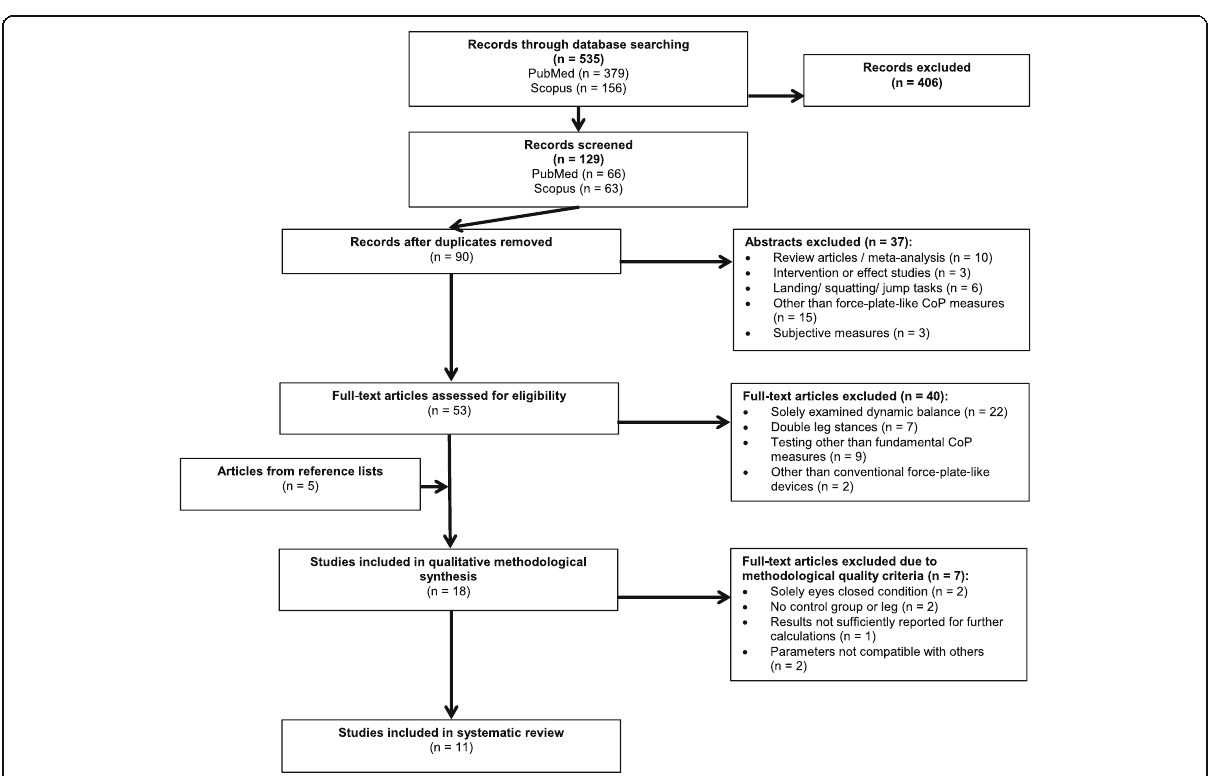
Fig. 1 PRISMA flow diagram of literature search process. CoP center of